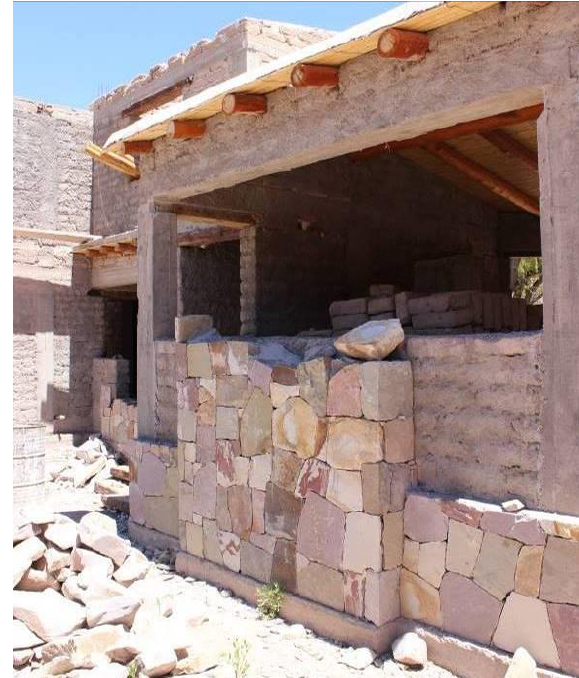
Figure 7. Wooden brace placed below a reinforced concrete beam in a new house © Authors.